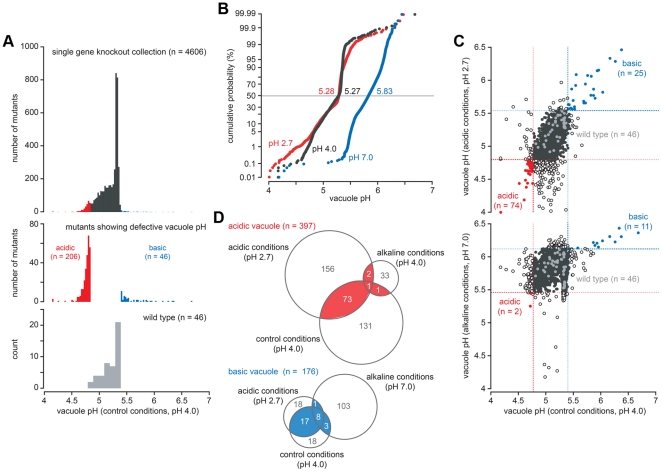
A genome-wide screen for mutations that disrupt vacuole pH in yeast.(a) Distribution of vacuole pH values at external pH 4.0. Top panel, a histogram showing the distribution of vacuole pH values observed in the ResGen collection of single gene knockout strains (n = 4606). Outliers (middle panel) fall beyond the distribution of vacuole pH values measured in wild type cells (bottom panel, n = 46). (b) Cumulative probability plots showing the distribution of vacuole pH values measured in the mutant collection at external pH 2.7 (acidic conditions, n = 4469; red), pH 4.0 (control conditions, n = 4606; black) or pH 7.0 (alkaline conditions, n = 4593; blue). Median values are shown for each population (indicated by the horizontal line). (c) Vacuole pH values from the mutant collection grown under acidic conditions (top) or alkaline conditions (bottom) were compared to values measured under control conditions. Minimum (red lines) and maximum (blue lines) pH values observed in the wild type population (light grey points) are indicated for each condition. Mutants with abnormally acidic (red) or alkaline (blue) vacuole under both conditions are highlighted; black closed circles indicate mutants with normal vacuole pH values, black open circles are mutants with abnormal vacuole pH values observed under a single condition. (d) Venn diagram displaying the distribution of outliers identified under all three conditions. ∼20% of the mutants displayed either hyperacidic vacuoles (red, n = 77) or alkaline vacuoles (blue; n = 27) in at least two growth conditions with different pH; these are listed in Table S3.